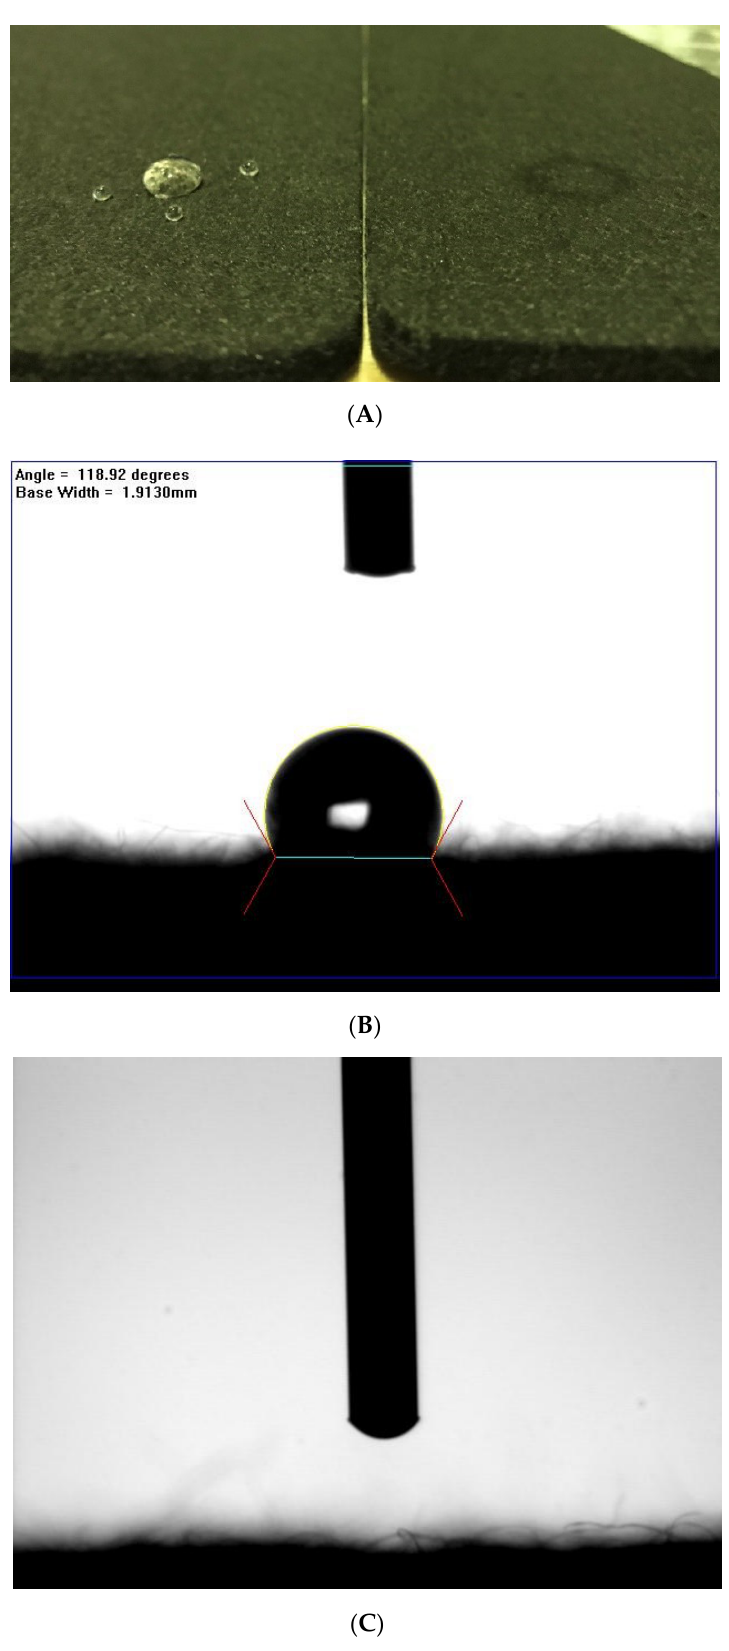
Figure 2. ( A ) The water dropping image of (left) the pristine felt and (right) the atmospheric plasma treated felt, the contact angle of ( B ) the pristine felt, and ( C ) the atmospheric plasma treated felt.